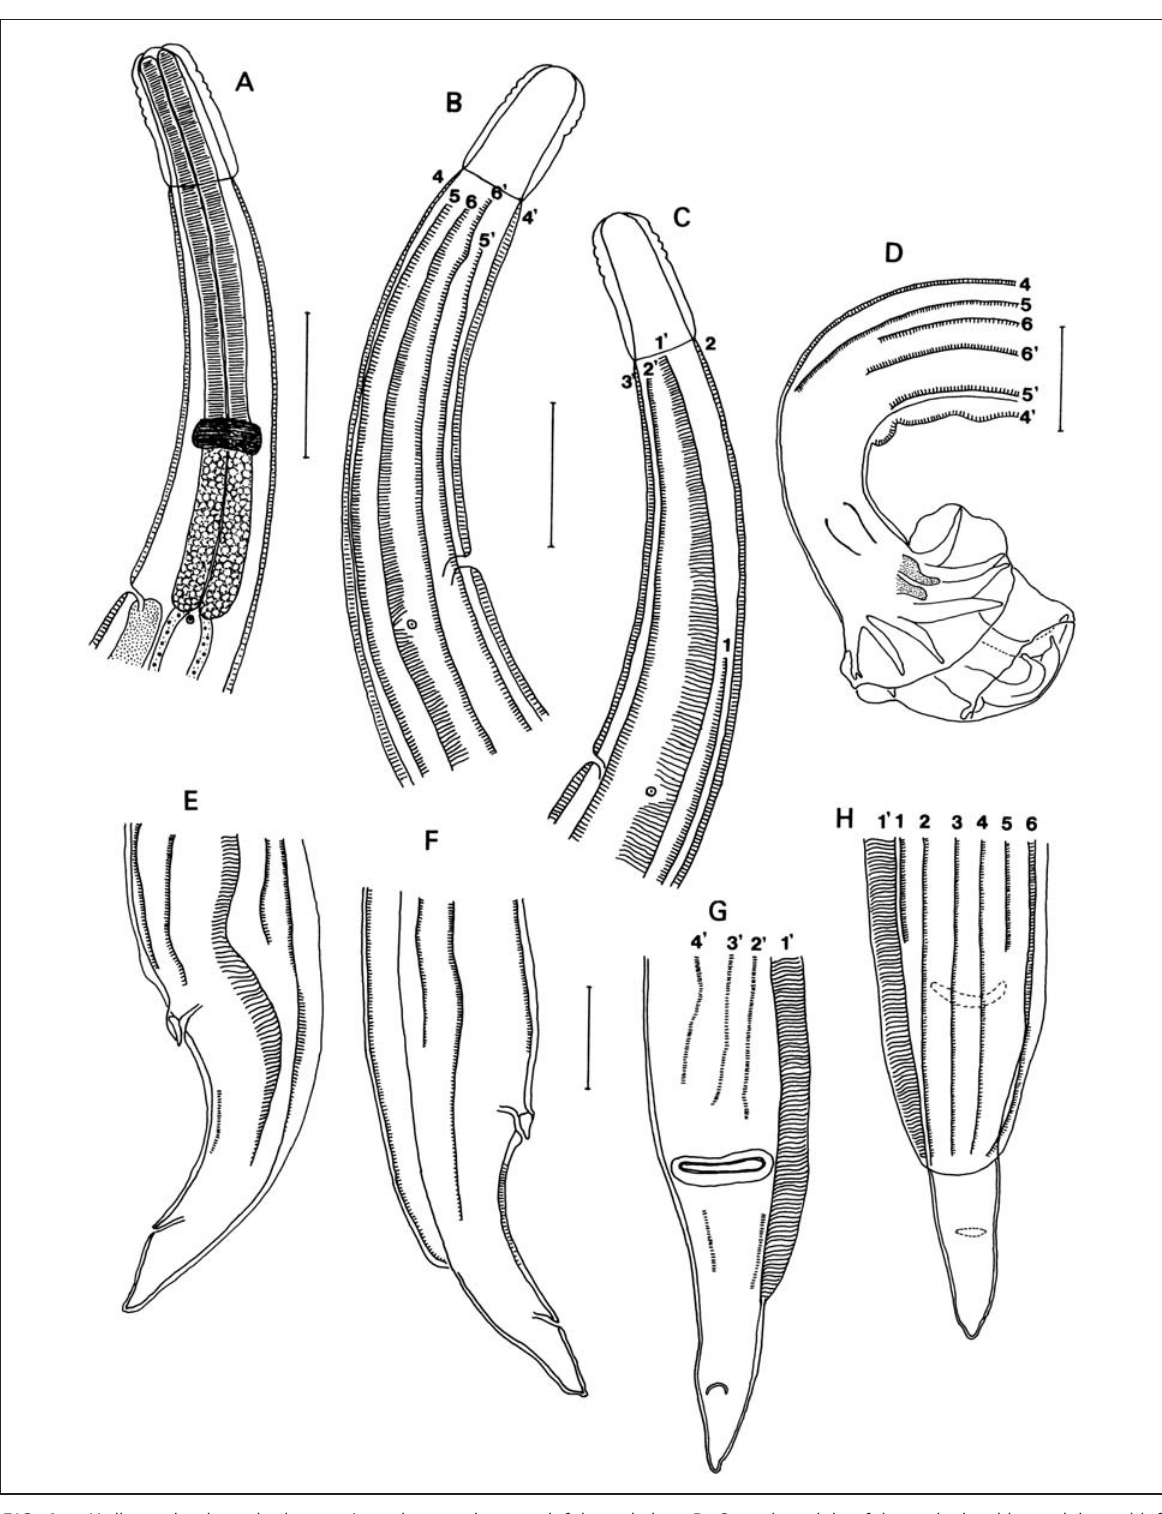
FIG. 1 Heligmonina boomkeri n. sp. A, male, anterior part, left lateral view. B, C, male, origin of the cuticular ridges, right and left lateral views. D–H, posterior part where the ridges disappear. D, male, right lateral view; E–H, female, E, left lateral view, F, right lateral view, G, ventral view, H, dorsal view The ridges are numbered from left to right from no. 1– n for the dorsal side, no. 1'– n ' for the ventral side Scales: 50